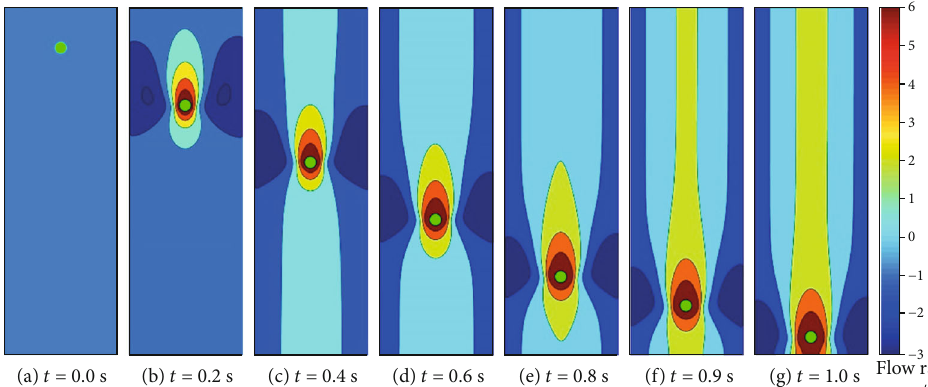
Figure 5: Particle movement and fl uid velocity contours at di ff erent